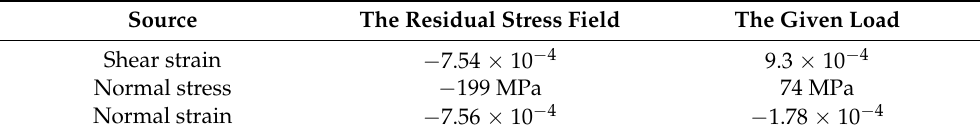
Table 5. The stress and strain components of the critical plane.